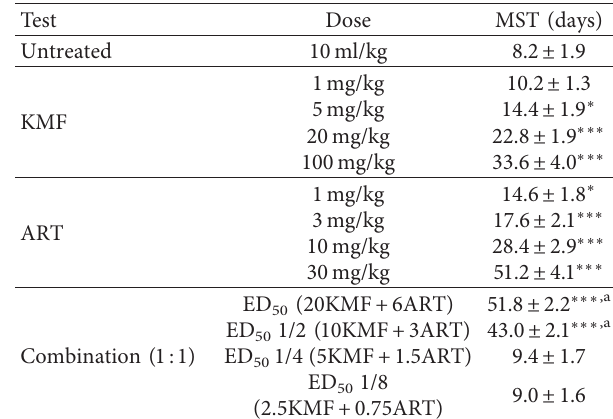
Table 2: Effect of combination treatment between artesunate and kaempferol on mean survival time of Plasmodium berghei ANKA- infected